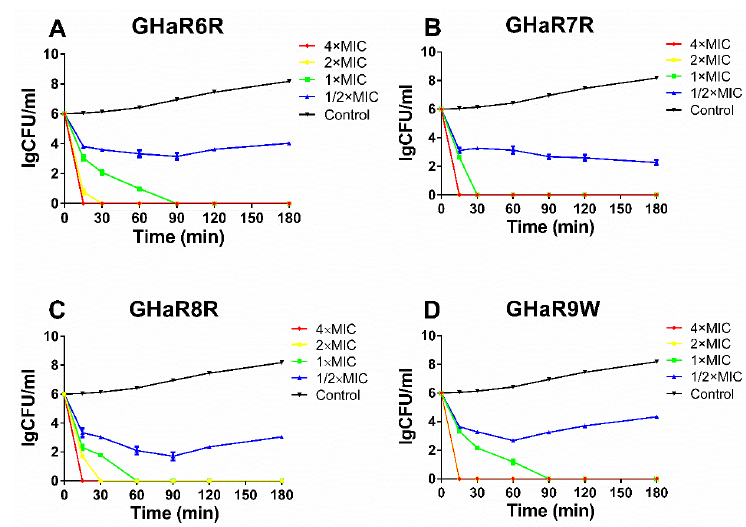
Figure 4. The killing assays of ( A ) GHaR6R, ( B ) GHaR7R, ( C ) GHaR8R, and ( D ) GHaR9W against S. mutans at 4 × MIC, 2 × MIC, 1 × MIC, and 1/2 × MIC. The bacteria untreated with the peptides served as the negative control.